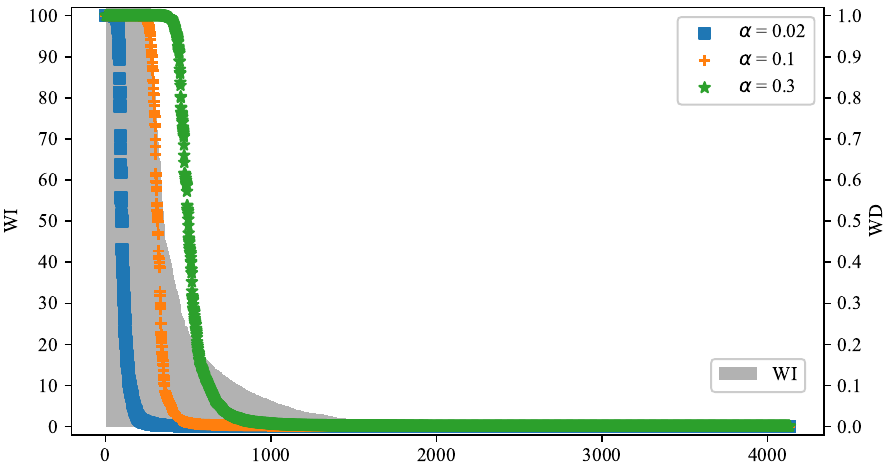
Figure A2. The water intensity (WI) for different countries and the virtual water dependence (WD)